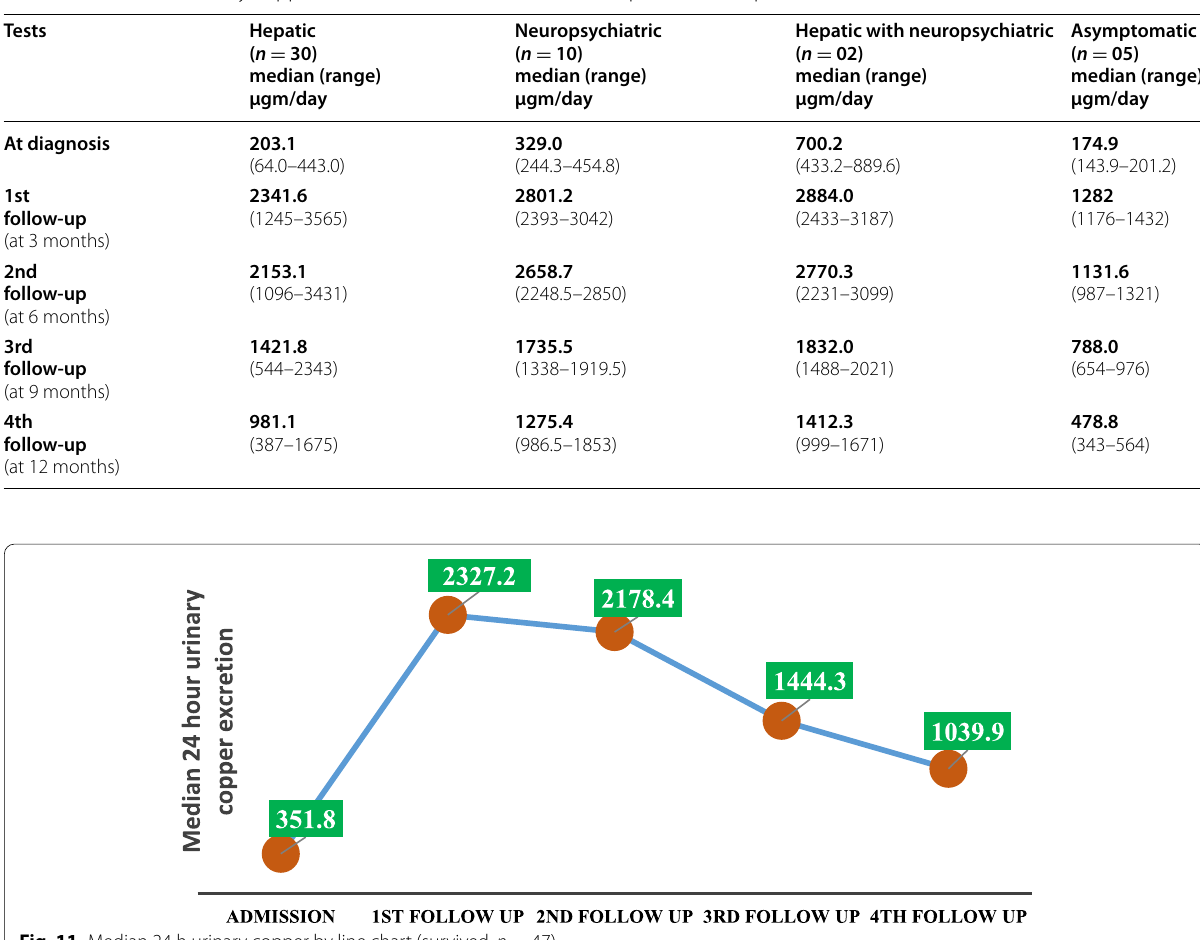
Table 3 Mean 24 h urinary copper excretion at admission and subsequent follow-up (survived, n